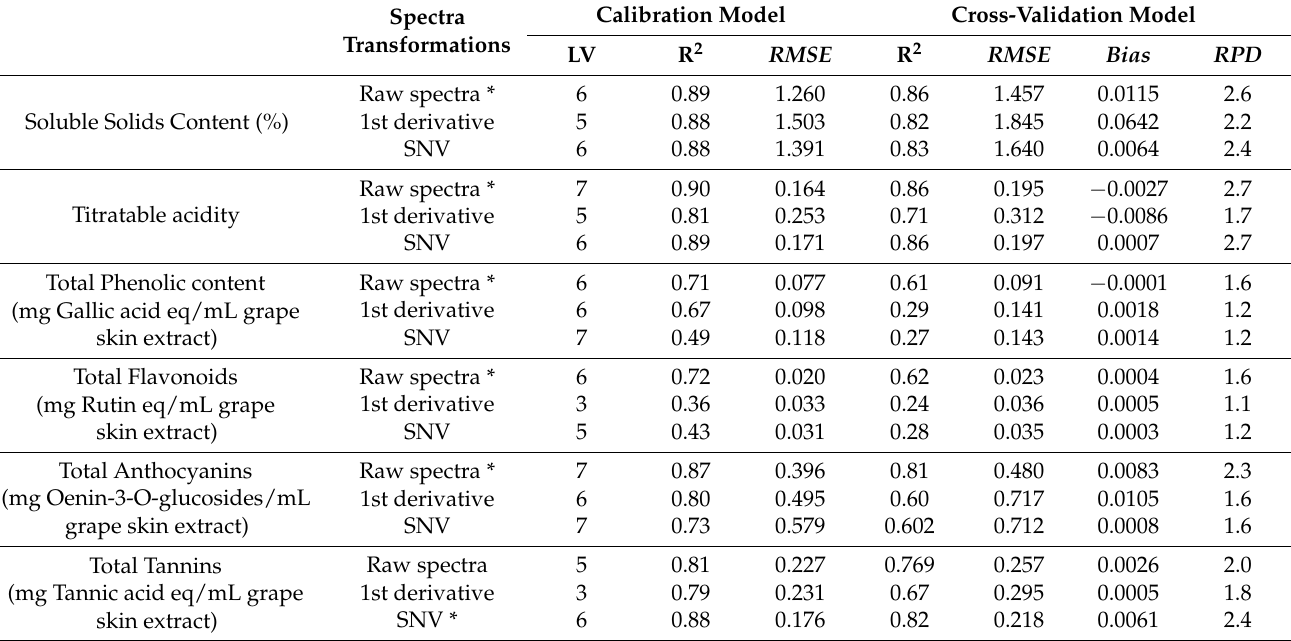
Table 3. Statistical parameters to characterize the quality of the final models to quantify total phenolic content, flavonoids, anthocyanins, and tannins in entire